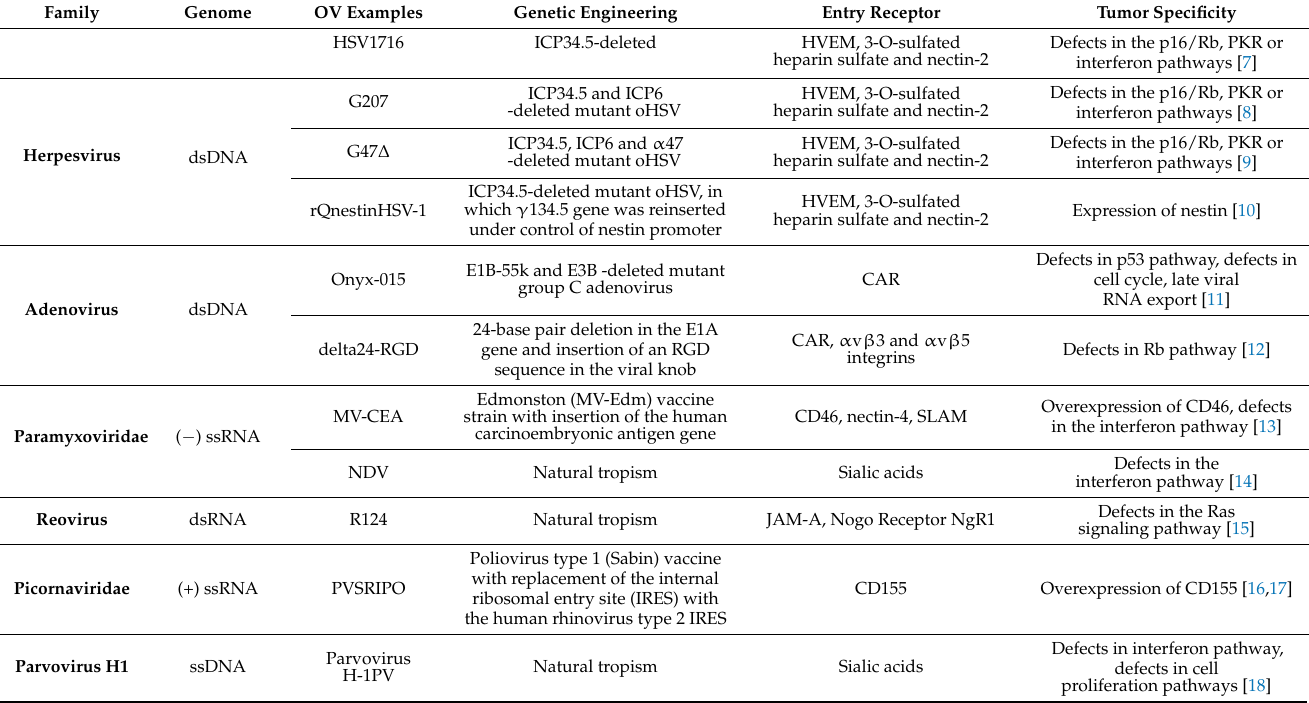
Table 1. Characteristics of the most commonly used Oncolytic viruses (OVs) in glioblastoma multiforme (GBM) clinical trials. Family